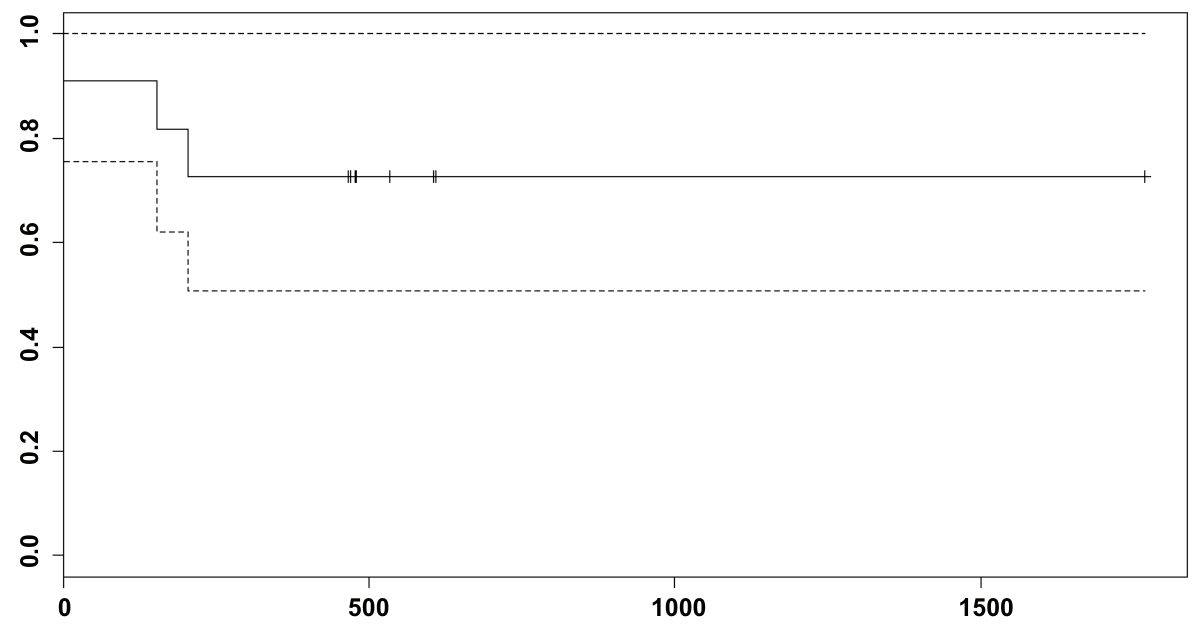
Figure 17. Actual survival curve for 11 patients with peritoneal carcinomatosis from any origin who were treated at a maximal temperature lower than 39°C.